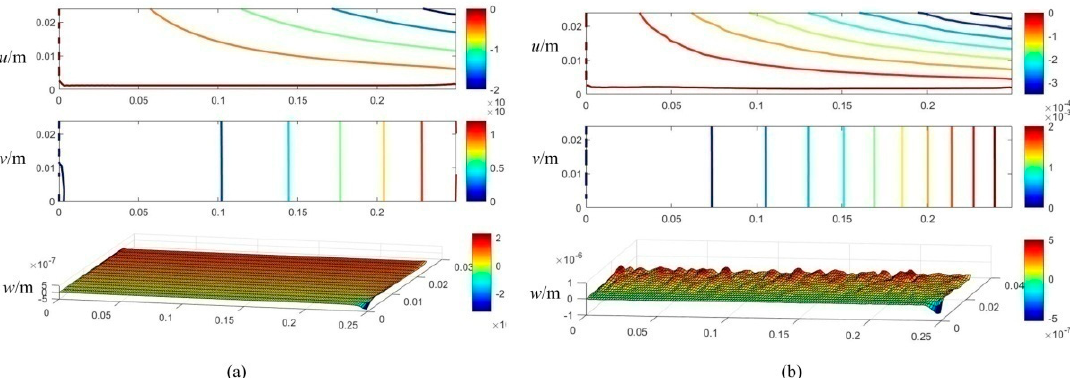
Figure 8. Structural response with bending moment M z ( a ) without wrinkles and ( b ) with randomly distributed wrinkles.